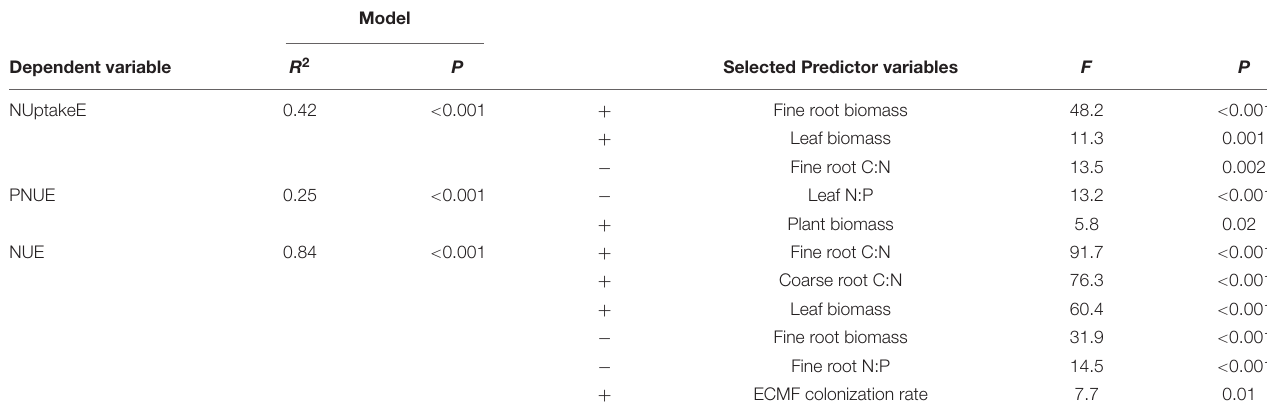
TABLE 1 | Three independent multiple regression analyses on the effects of multiple predictor plant traits on N uptake efficiency (NUptakeE), photosynthetic N use efficiency (PNUE), or N use efficiency (NUE).